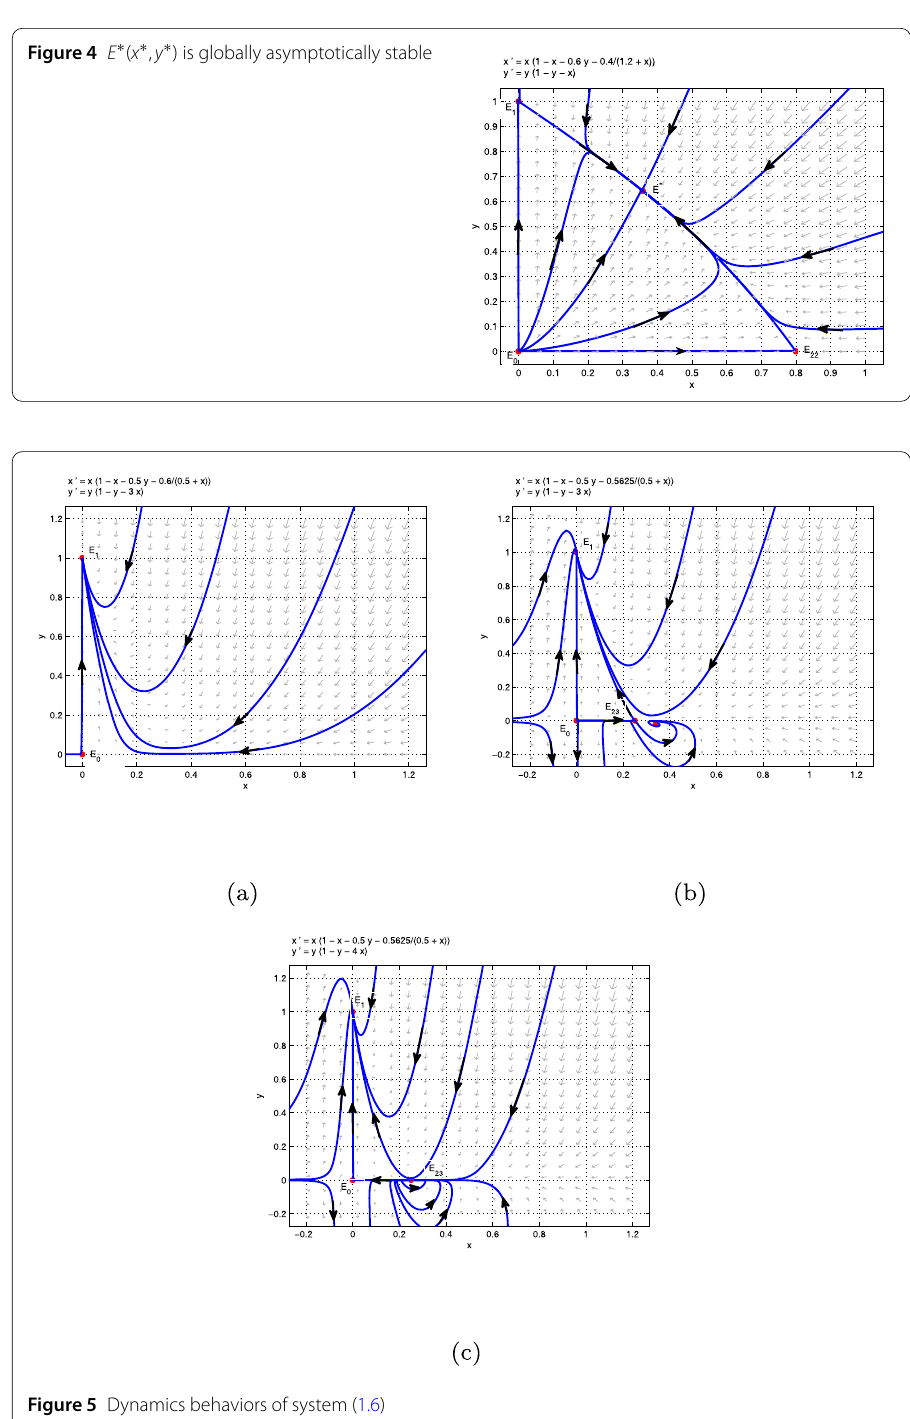
Figure 5 Dynamics behaviors of system